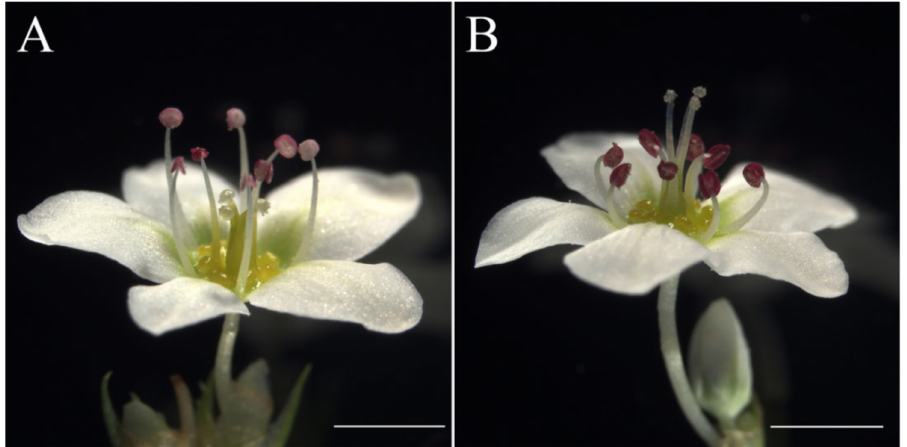
Figure 1. Distylous flower of F. esculentum. ( A ) Thrum flower with short pistil and long stamen; ( B ) pin flower with long pistil and short stamen. Scale bar = 2